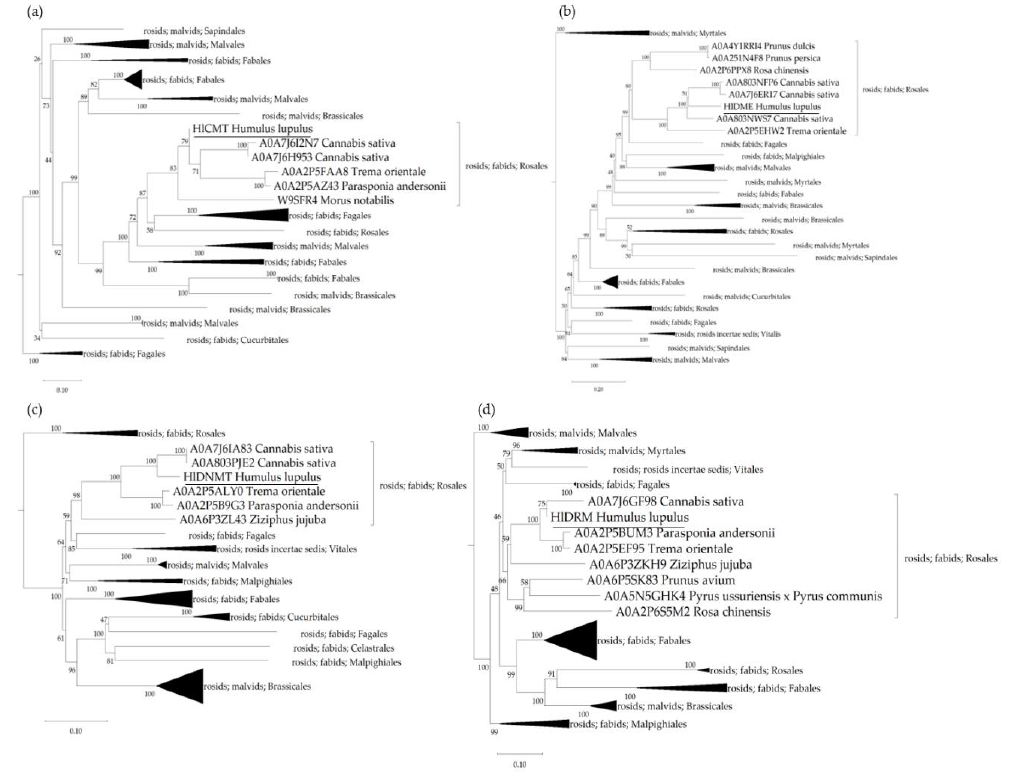
Figure 3. Phylogenetic trees of the Chromomethylase (CMT), Demethylase (DME), DNA methyl- transferase (DNMT), and Domains Rearranged Methyltransferase (DRM) proteins for the selected plant species (Supplementary Table S2), containing the newly identified DNA methylases and de- methylases in hop. The polypeptide sequences were aligned using the MUSCLE algorithm, and the maximum likelihood phylogeny based on the WAG protein substitution model was used to con- struct the neighbour-joining trees for the ( a ) CMT, ( b ) DME, ( c ) DNMT, and ( d ) DRM protein groups. The numbers above the nodes indicate the reliability of 1000 bootstrap replicates. Scale bars represent amino acid substitutions per site. The software MEGA11 was used for the visualisation of the phylogenetic trees [54] .